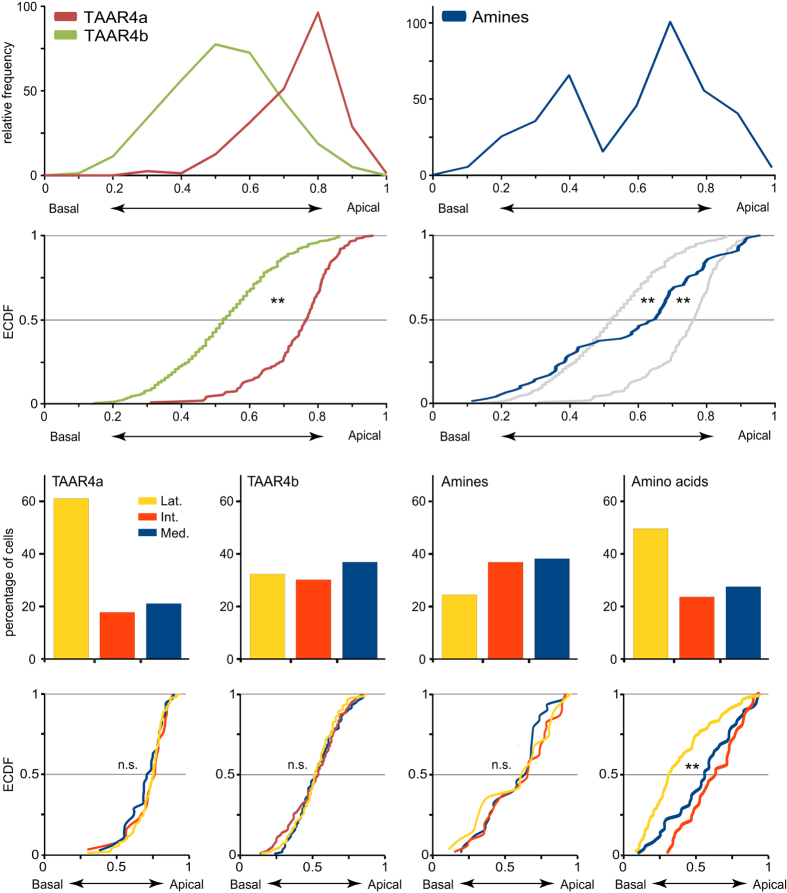
Quantitative analysis of spatial patterns.Basal-to-apical distributions were quantified for olfactory receptor genes and odor responses. Top row, receptor gene (left panel) and odor response (right panel) distributions are shown as histogram of relative height (0, most basal; 1, most apical position; bin size 0.1, bin center is shown). Left panel, taar4a (brown) is centered apical; taar4b (green) shows a basal peak. Right panel, amine responses (blue) show a bimodal distribution. Second row, distributions are depicted as empirical cumulative distribution function (ECDF). Color code as above, for comparison to the amine responses the receptor distributions are shown in grey in the right panel. **p < 0.01. Third row, medial-to-lateral distribution is shown as bar graph for TAAR4a, TAAR4b, amine responses, and amino acid responses (values taken from2 for comparison). Bottom row, basal-to-apical distributions are shown independently for each segment of the medial-to-lateral distribution depicted above. Medial segment, blue; intermediate segment, red; lateral segment yellow. Note that for both taar genes and amine responses the height distribution is undistinguishable between segments, in contrast to the significant difference between lateral and non-lateral amino acid responses (right panel). **p < 0.01.